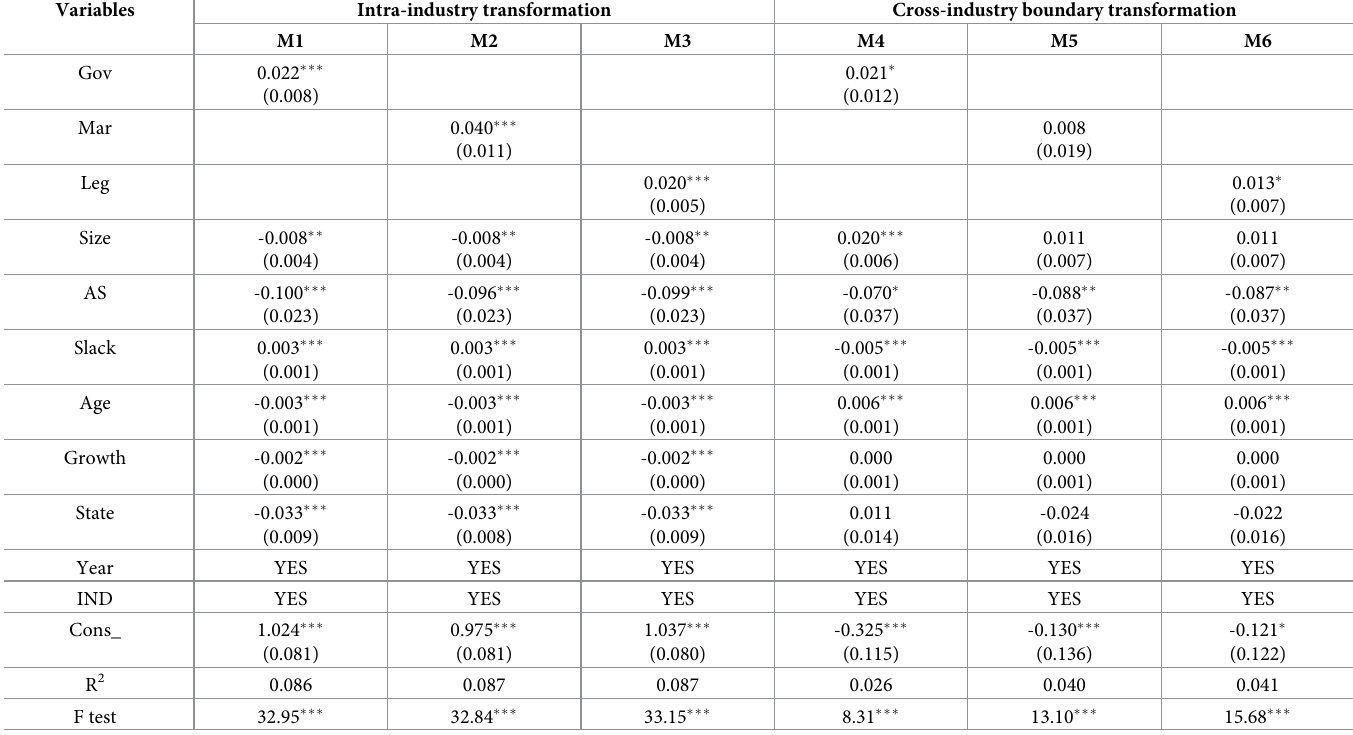
Table 4. Impact of institutional environment on the service-oriented transformation of manufacturing